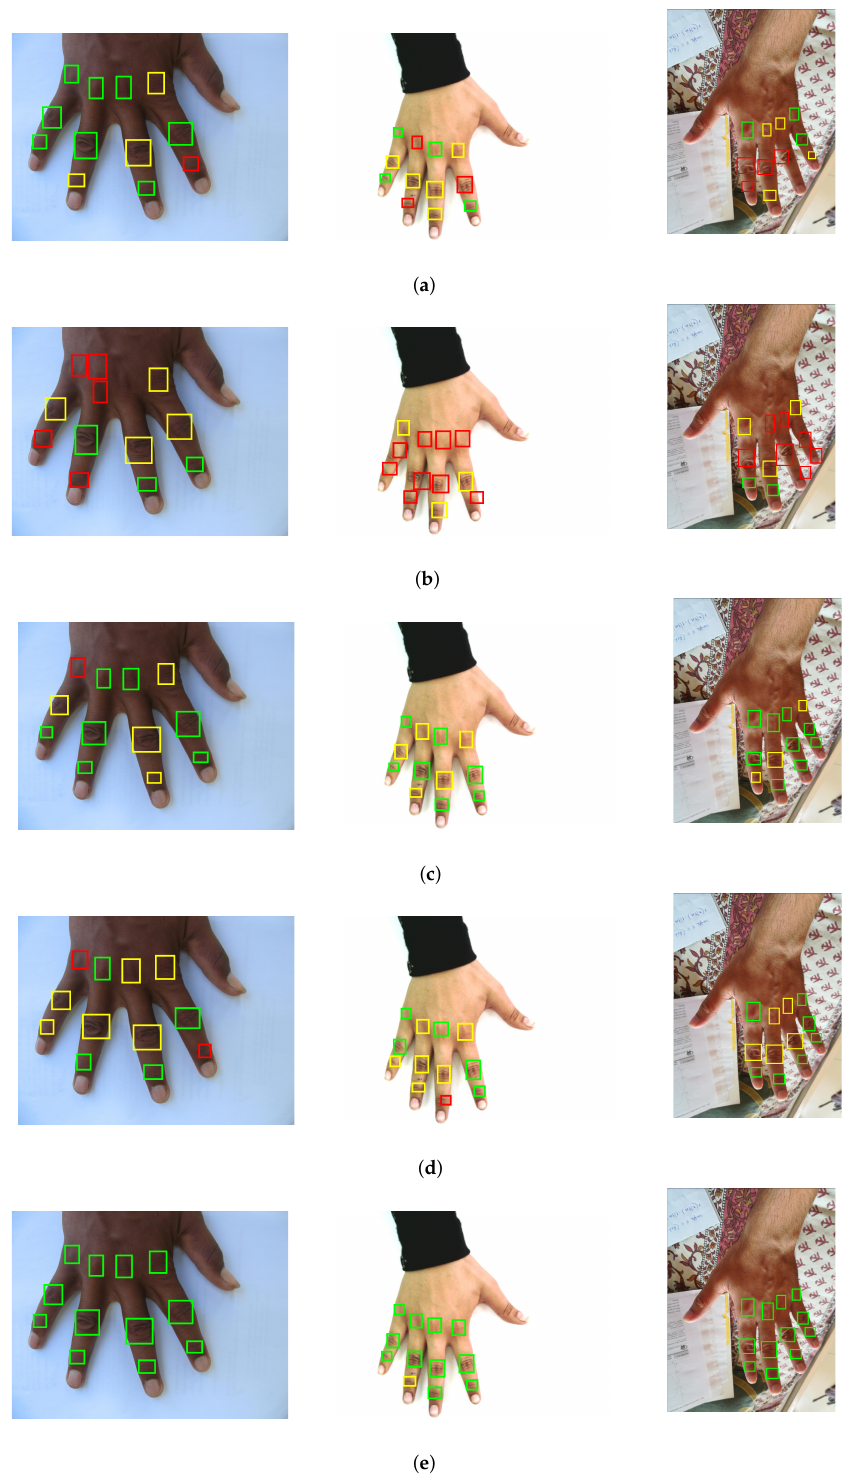
Figure 3. Samples showing knuckle localization for various approaches; for (left-column) HD, (middle-column) 11k, (right-column) HUQ dataset. Different colored boxes correspond to different types of regions: Green: Acceptable; Yellow: Borderline; and Red: Unacceptable knuckle predictions (refer to the web version for colors). Predictions are shown for ( a ) Yolo-v3, ( b ) Yolo-v2, ( c ) Faster R-CNN (ResNet50), ( d ) Faster R-CNN (ResNet101), and ( e ) WBF